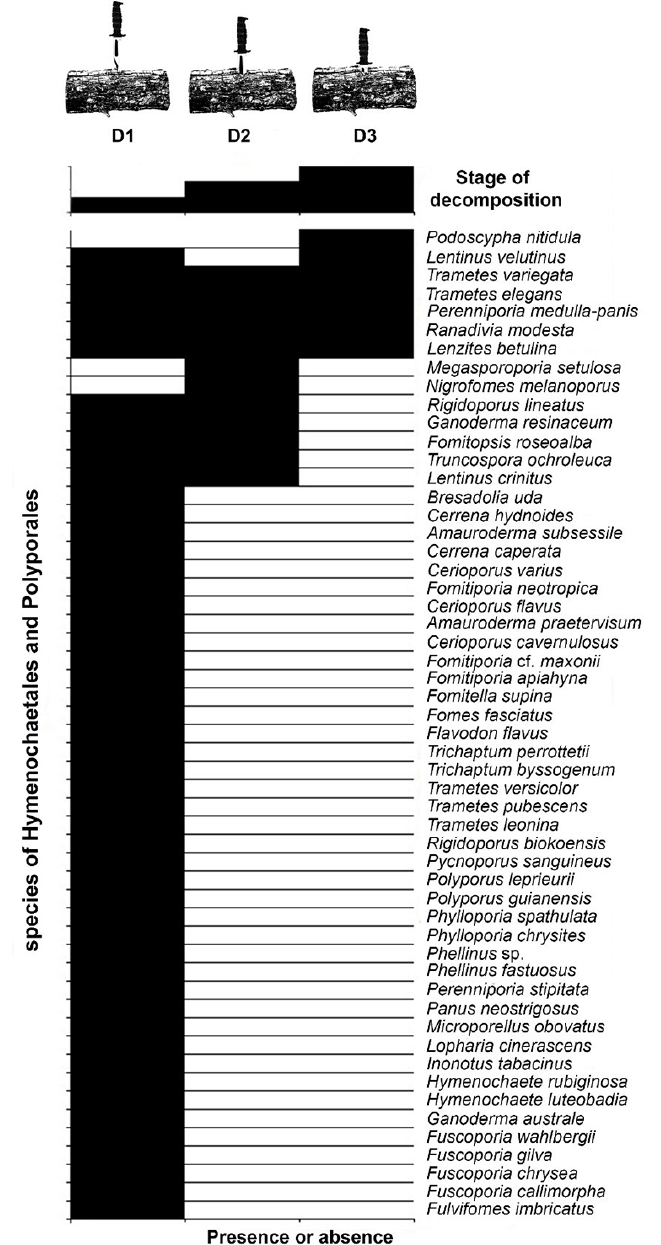
Figure 6. Ordering of Hymenochaetales and Polyporales species found at different stages of decomposition wood (D1 = rigid, D2 = intermediate and D3 = fragile) near the Silvio Braga HPP, Santarém,